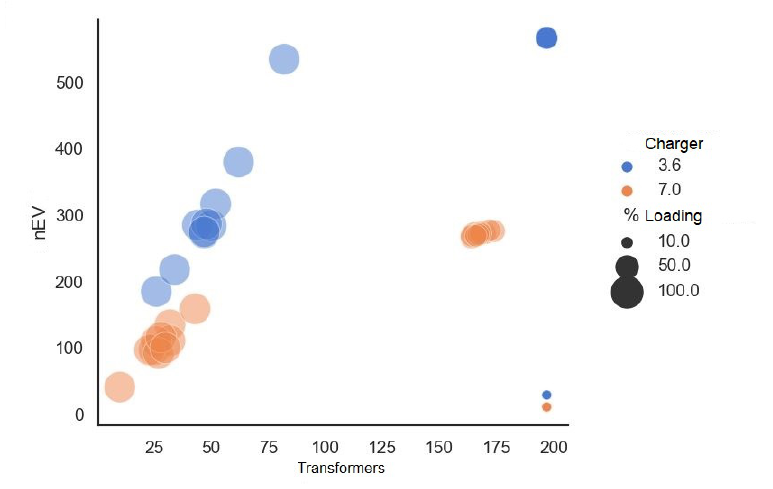
Figure 11. Detailed medium-voltage HC—Feeder 16.